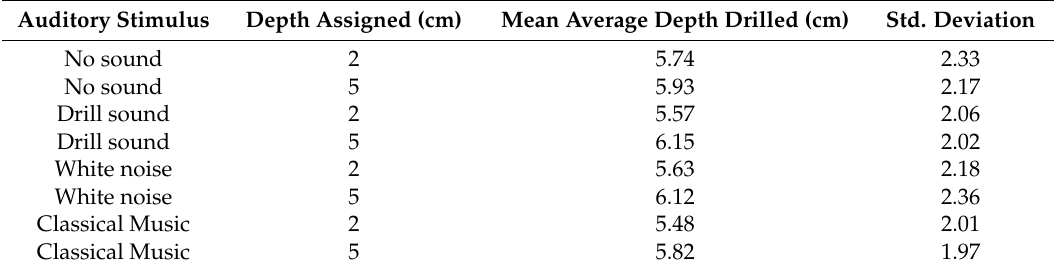
Table 2. Between-subject factors by